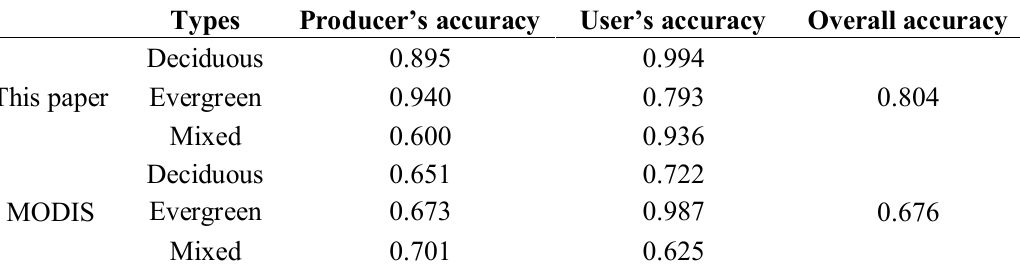
Table 3. Accuracy of